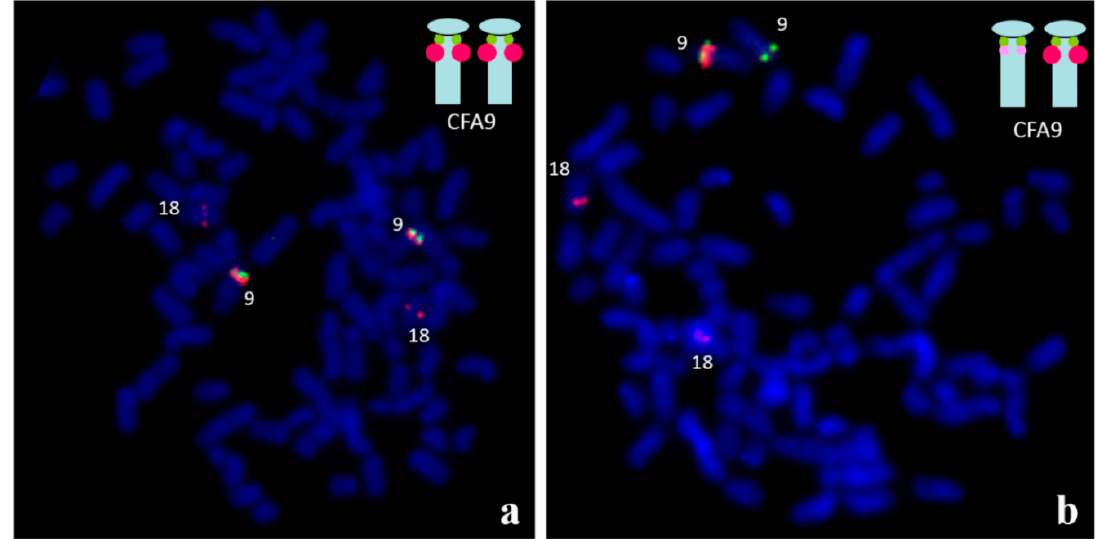
Figure 4. Identification of the copy number variation (CNV) in the region of SOX9 , located on CFA9. Two BAC (Bacterial Artificial Chromosome) clones were used: the green signals are specific to the SOX9 gene and the red signals are specific to the upstream CNV. The red probe also presents homology to CFA18. ( a ) The two large red signals on CFA9 indicate multiplication of the CNV region. ( b ) Another example of the variation - the single large, red signal is visible on one CFA9 chromosome,